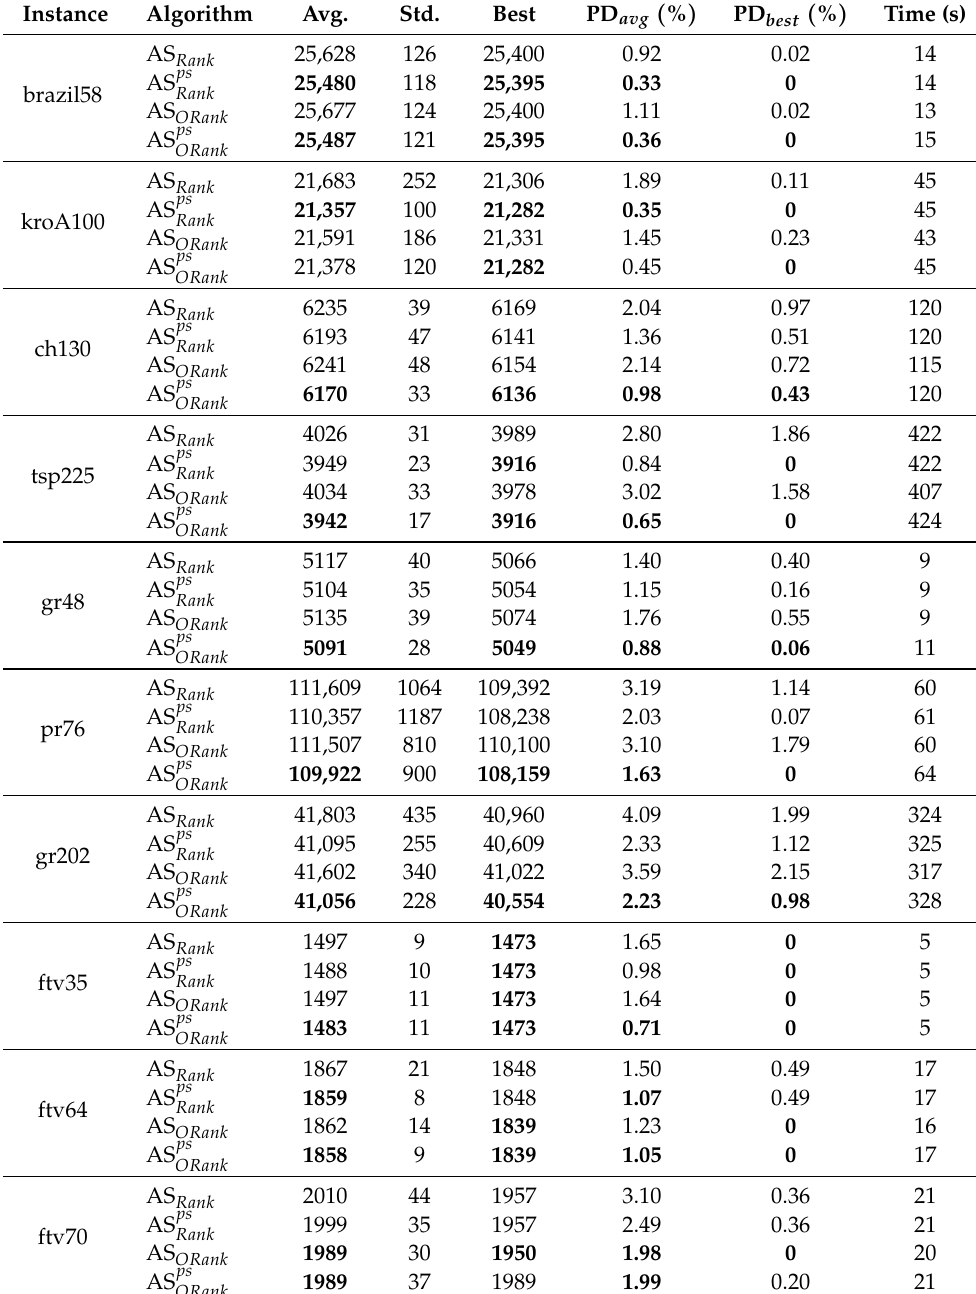
Table 3. Results for symmetric and asymmetric TSP instances obtained by Rank-based ACO variants. The best results for each problem instance are highlighted in